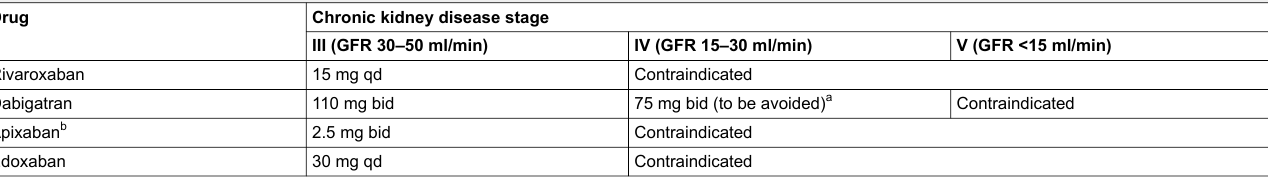
Table 5: Dosing recommendations for direct oral anticoagulants in patients with chronic kidney disease. Dosing regimens are mostly derived from studies for stroke prevention in atrial fibrillation (see